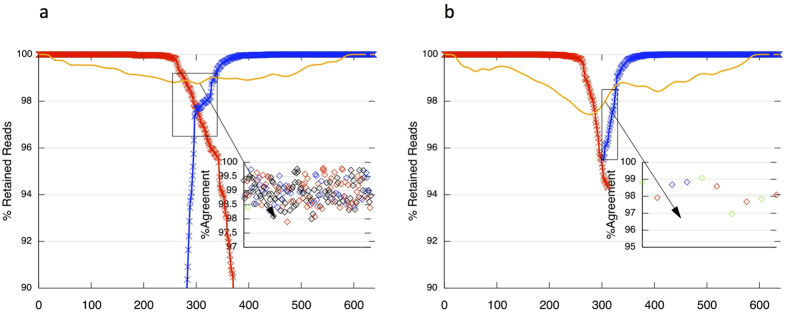
Extended Illumina MiSeq reads for high throughput rbcL reference barcoding.The standard protocol of the Illumina V3 MiSeq 2 × 300 kit was changed from a bidirectional to a unidirectional format (Extended Unidirectional Sequencing, EUS). The panels above indicate the proportion of EUS reads passing filter in the forward (red line) or reverse (blue line) directions only, and show the percentage consensus agreement (orange line) at each base position for: (a) the best example profile for rbcL (Rhagodia spinesens X98); (b) the worst example profile for rbcL (Eremophila scoparia M56B). Inset shows base-by-base consensus agreement in boxed area.